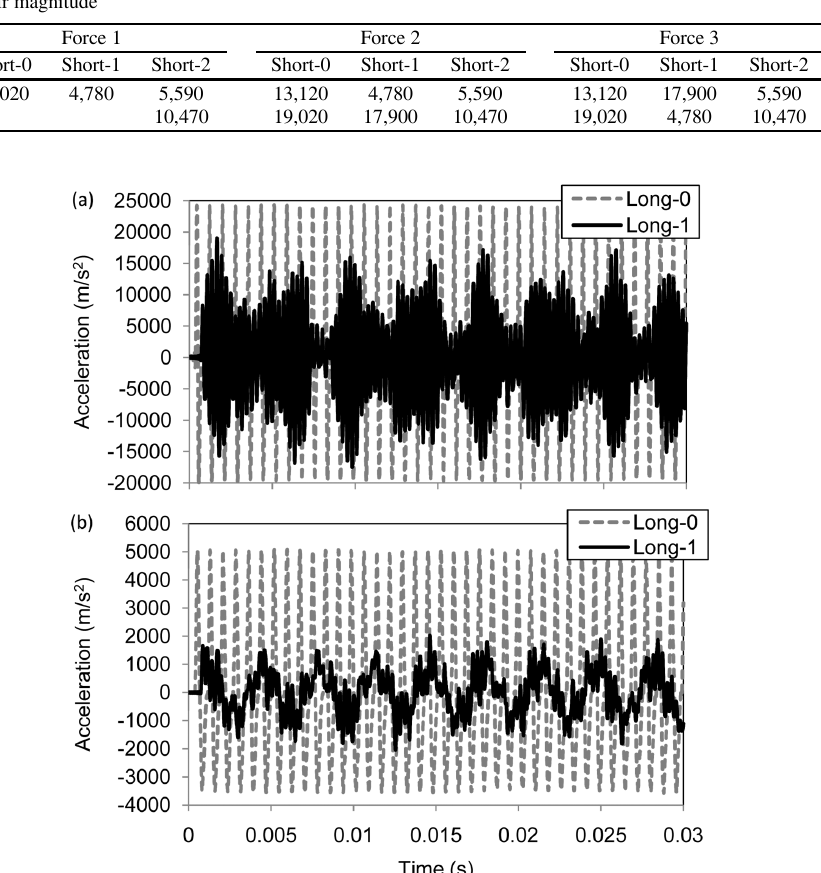
Fig. 12. Computational results of acceleration responses of long structures under impact loading using (a) hard and (b) medium tip impacts. 10,000 Hz cutoff frequency is used for low-pass fi lter. does not interfere with the re fl ected back wave from the end of any structure (‘Short-0’, ‘Short-1’ and ‘Short-2’). Maximum magnitude of 19,996 N for ‘Force 2’ and 39,992 N for ‘Force 3’ were calculated based on the impulse of ‘Force 1’. All three forces have similar impulses but range of excitation frequencies increased when magnitudes increased similar to the experimentally applied impact forces. Forces 1, 2 and 3 have the ranges of approximately 6,000, 16,000 and 32,000 Hz, respectively. Interference between the applied force and the re fl ected back wave was nylon are approximately 5,000 m/s, 1,500 m/s and 1,200 m/s, respectively. Single lap traveling times of ‘Short-0’, ‘Short-1’ and ‘Short-2’ are about 6.1E-5, 1.1E-4 and 1.1E-4 seconds, respectively. Therefore, the impact